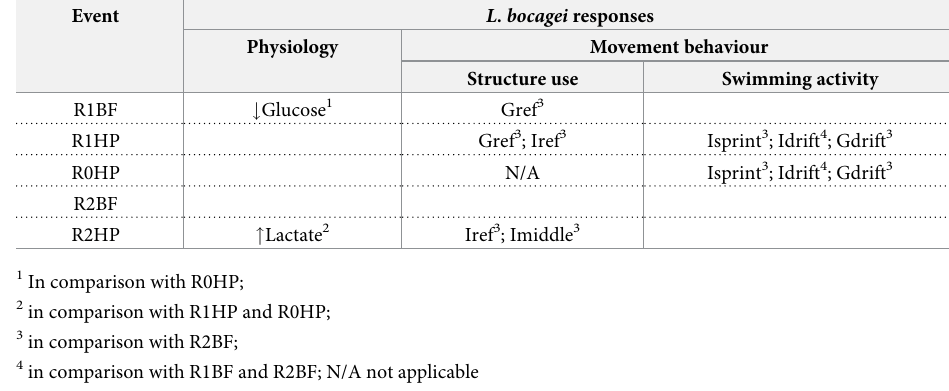
Table 2. Summary of the comparisons of the physiological and behavioural responses of L . bocagei between events tested. The direction of physiological responses is indicated ( " higher, # lower). The frequency of the shown move- ment behaviour metrics was higher in that event in comparison to those indicated (number).